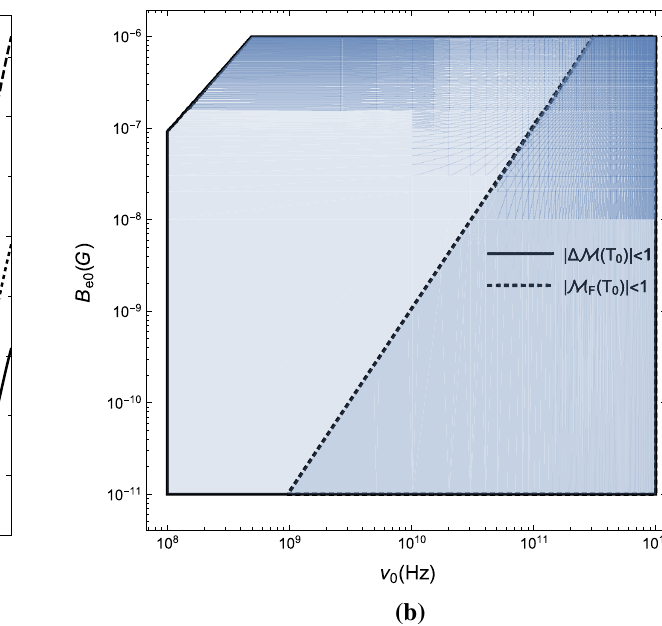
Fig. 1 In a logarithmic scale plots of the ionization function X e ( T ) (dimensionless), X e ( T ) T 1 / 2 (in units of K 1 / 2 ) and X e ( T ) T 3 / 2 (in units of K 3 / 2 ) as a function of the CMB temperature T ∈ [ 2 . 725 , 2970 ] (K) are shown. In b logarithmic scale region plots of the stronger conditions (30) and (31) of | M F ( T 0 ) | < 1 and | (cid:23) M ( T 0 ) | < 1 only as functions